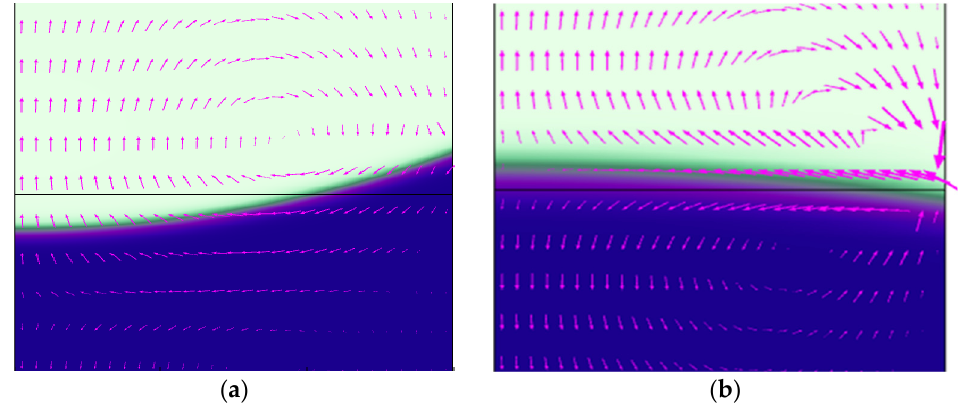
Figure 6. ( a , b ) The simulation diagrams of the curvature of the phase interface when the contact angles are 60° and 140°, respectively. The arrows in the figure are the directions of the gas phase particle velocity vector, the liquid phase is blue, and the gas phase is green.